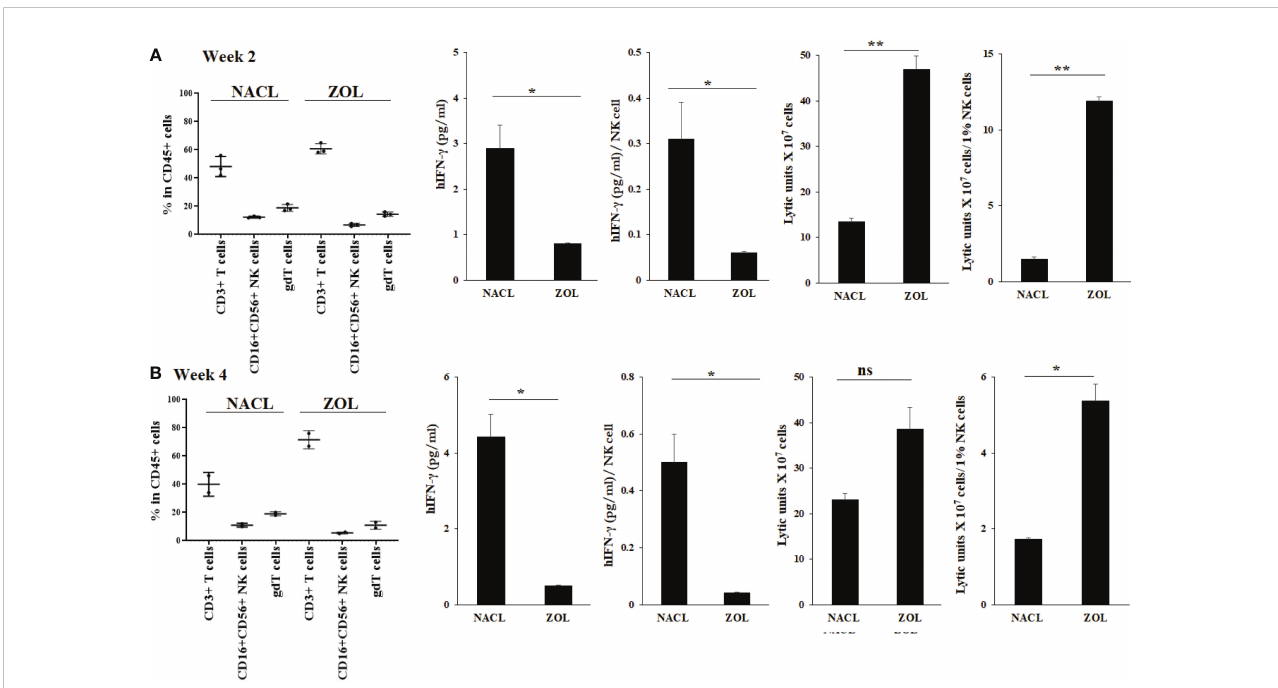
FIGURE 3 Human CD45+ immune cell percentages, IFN- g secretion and NK-cell mediated cytotoxicity in oral gingival cells of NACL or ZOL-injected and tooth extracted hu-BLT mice. Hu-BLT mice were administered with either 0.9% NACL or ZOL (500 µg/kg) via IV followed by maxillary left fi rst molar extraction as described in Materials and Methods section. Two weeks (n=3) (A) and four weeks (n=2) (B) after injections, mice were euthanized and oral gingival tissues were harvested to obtain single cell suspension. Surface expression of CD45+CD3+, CD45+CD16+CD56+, and CD45+CD3+gdT+ in oral gingival cells were determined using fl ow cytometric analysis as described in the Materials and Methods. Oral gingival cells mice were cultured (2 × 10 6 cells/2ml) with IL-2 (1000 U/ml) for three days, after which the supernatants were harvested and the levels of IFN- g was determined using speci fi c ELISA. IFN- g secretion was determined per human CD45+ cells using human CD45+ percentages obtained by fl ow cytometric analysis. IFN- g per one NK cell were determined using CD16+CD56+ percentages obtained by fl ow cytometric analysis. Oral gingival cells were used as effector cells in standard 4-hour 51 Cr release assay against human OSCSCs tumors. Lytic units (LU) 30/10 6 cells were determined using inverse number of effector cells required to lyse 30% of OSCSCs × 100. LU per 1% NK cells were determined using CD16+CD56+ percentages obtained by fl ow cytometric analysis (A, B) . **(p value 0.001-0.01), *(p value 0.01-0.05) ns (no signi fi cance).